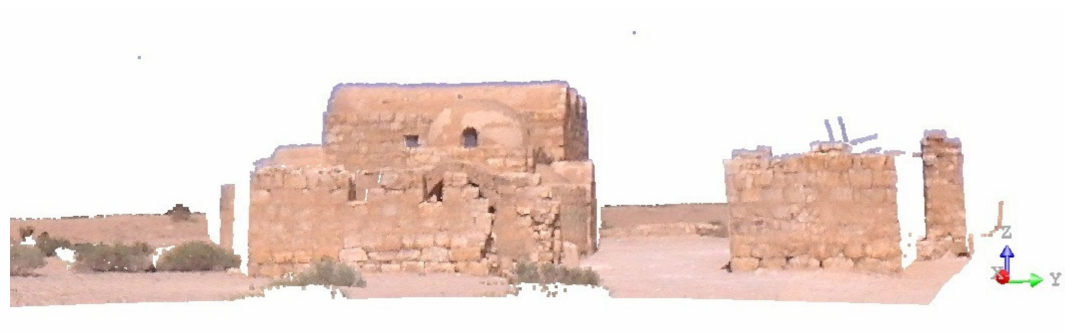
Figure 9. The distant acquisition of TLS data leads to low resolution color information.